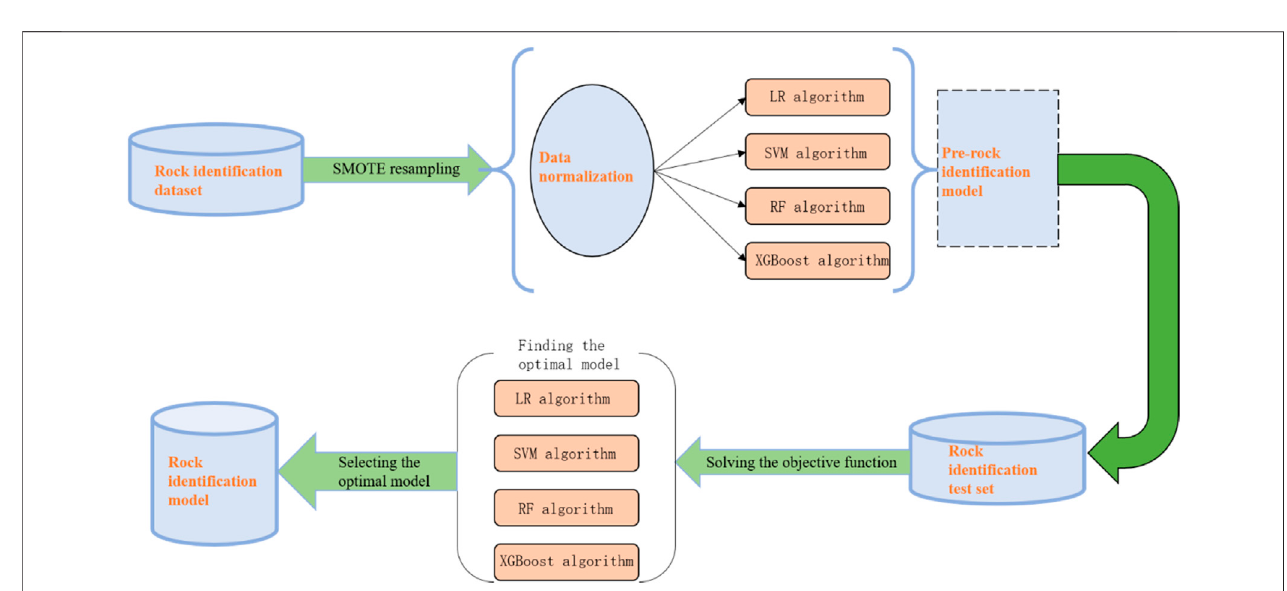
FIGURE 5 | Identi fi cation process of strata and reservoirs.